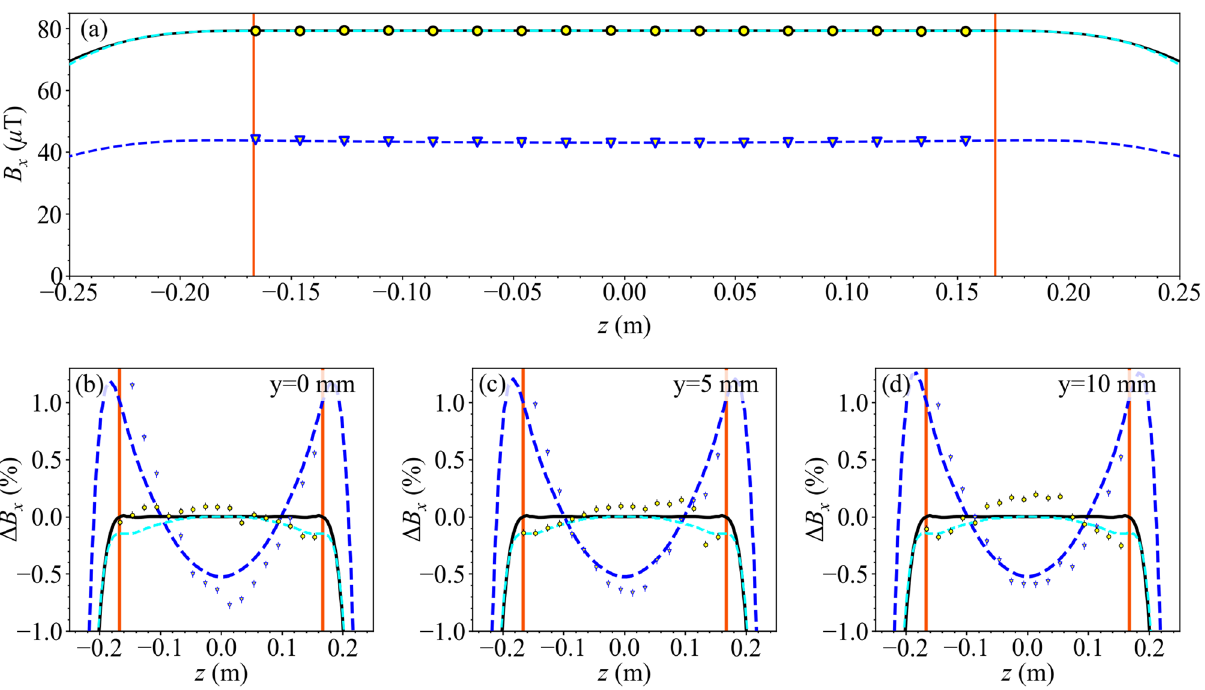
Figure 5. ( a ) Transverse magnetic field generated by the uniform B x coil (current I = 500 mA) with/without the magnetic shield (black/dark blue) evaluated along the z -axis. Scatter points (yellow circle/triangle with black/ dark blue outline) show measured data and lines show theoretical field profiles calculated analytically from the theoretical model (solid black) or numerically via the Biot–Savart law (dashed dark blue). An additional numerical simulation shows the field generated by the discrete coil configuration inside the standalone shield, excluding the atomic package (dashed cyan; COMSOL Multiphysics Version 5.3a). Overlaid lines (solid red) show the edges of the optimisation region. ( b – d ) Deviation from perfect uniformity of the normalised transverse field, (cid:31) B x = B x − 1 , along the z -axis, and displaced by ( x , y ) = ( 0, 5 ) mm and ( x , y ) = ( 0, 10 ) mm inside the optimisation region of radius ρ o = 10 mm. Labelled identically to ( a ).